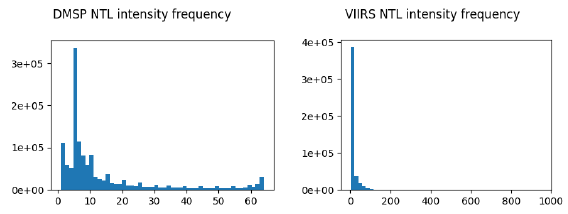
Figure 6 . Distributions of two NTL datasets with value < 1